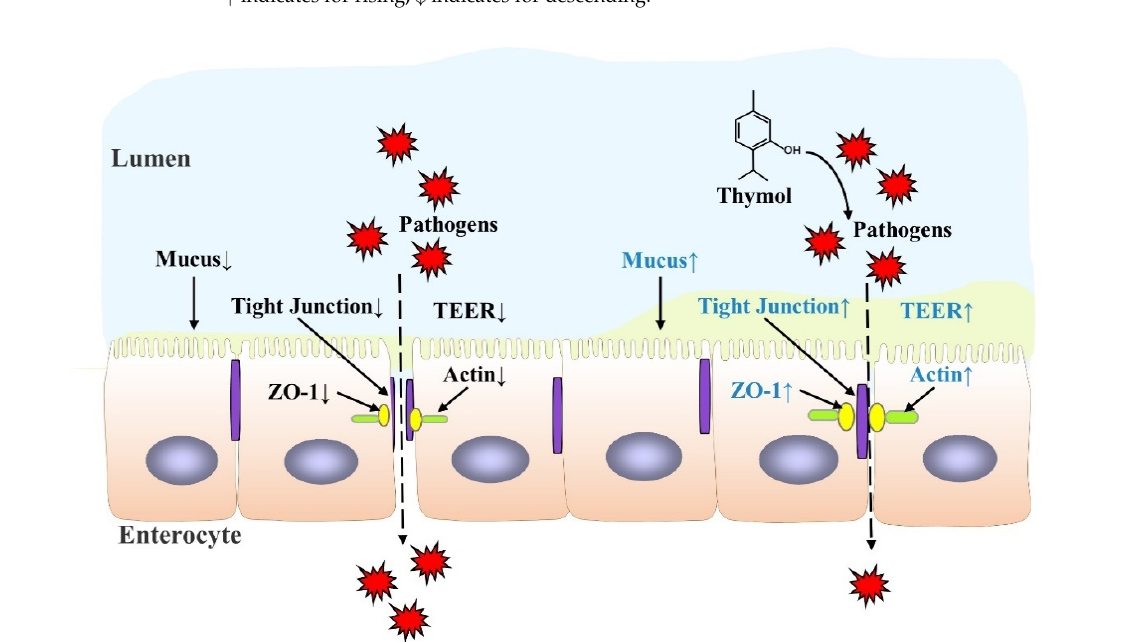
Figure 2. Action of thymol to protect intestinal barrier function. Pathogen infection in the intestinal lumen reduces mucus secretion and the expressions of tight junction proteins, and increases intestinal permeability, resulting in a “leaky gut”, which increases the risk of intestinal disease. Thymol has been shown to defend against pathogen invasion, promote mucus secretion, and enhance intestinal barrier integrity.